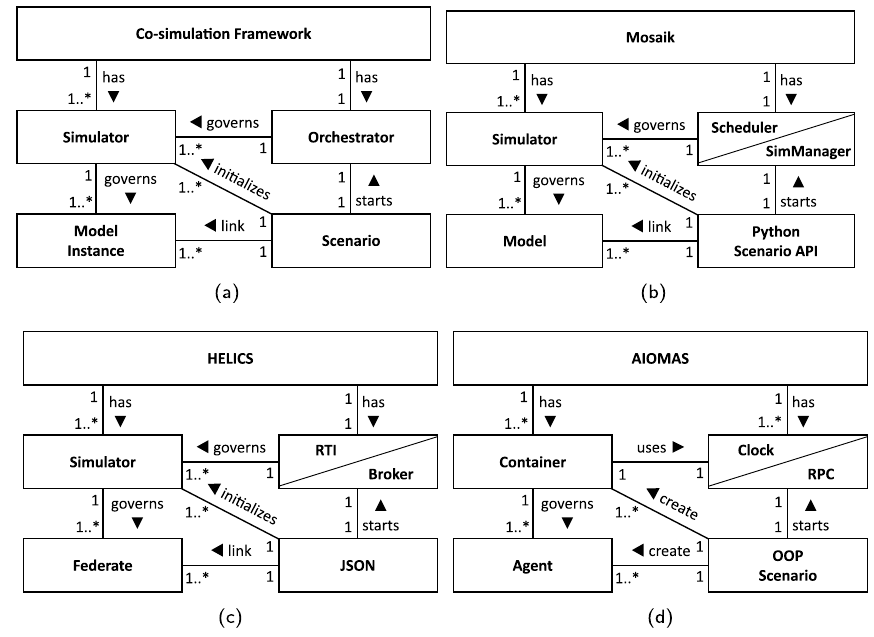
Fig. 2 Component relational schema of a general co-simulation framework ( a ) and its declination for Mosaik ( b ), HELICS ( c ), and AIOMAS ( d